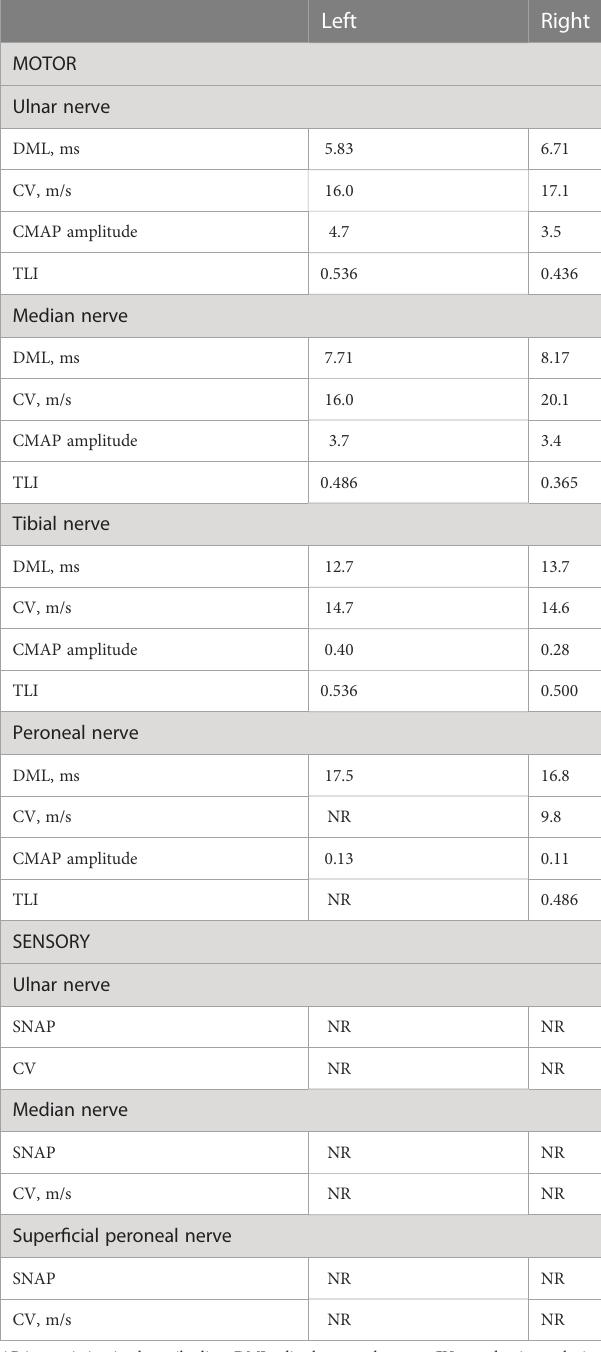
TABLE 1 Detailed electrophysiologic data of our patient with ARAs. Left